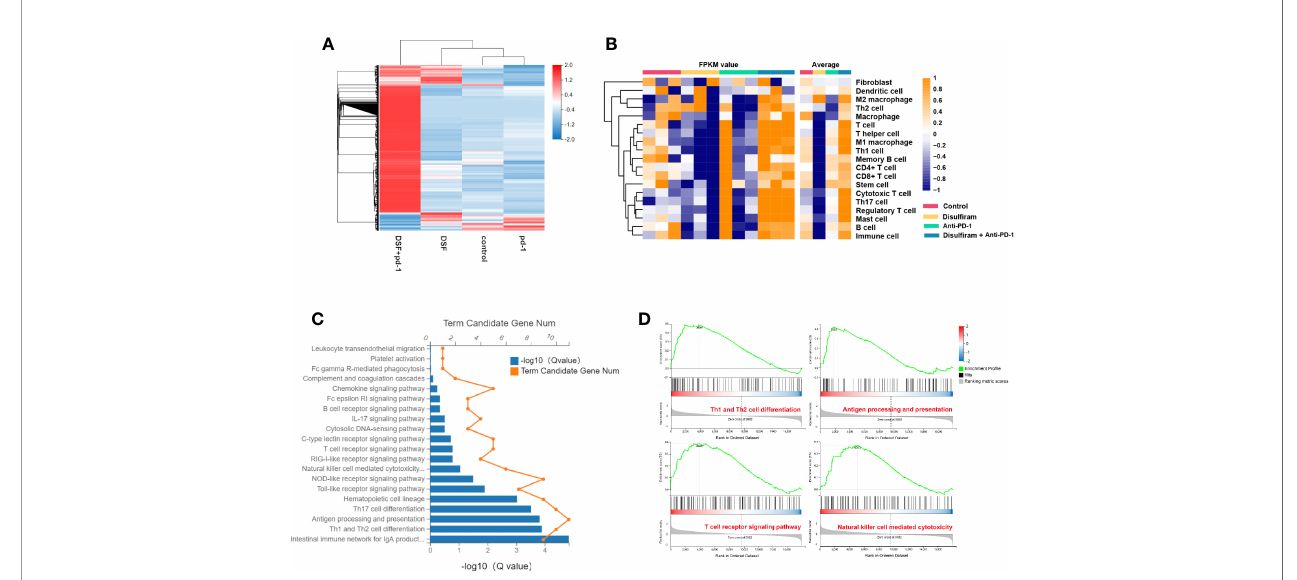
FIGURE 6 | The modulation of tumor immune microenvironment in the combination of DSF and anti-PD-1 therapy. (A) Heat map shows gene expression pro fi les of a selected list of the immune microenvironment showing fold changes in the groups of control, DSF, anti-PD-1 antibody, combination. (B) The MCP counter algorithm was utilized to analyze the degree of in fi ltration of immune cells with mRNA expression in the groups of control, DSF, pd-1, combination. (C) The Gene ontology (GO) and Kyoto Encyclopedia of Genes and Genomes (KEGG) functional enrichment analyses of mRNAs in the groups of control vs DSF. (D) KEGG functional enrichment analysis of the anti-PD-1 blocking antibody groups and the combination of DSF and the anti-PD-1 blocking antibody groups based on